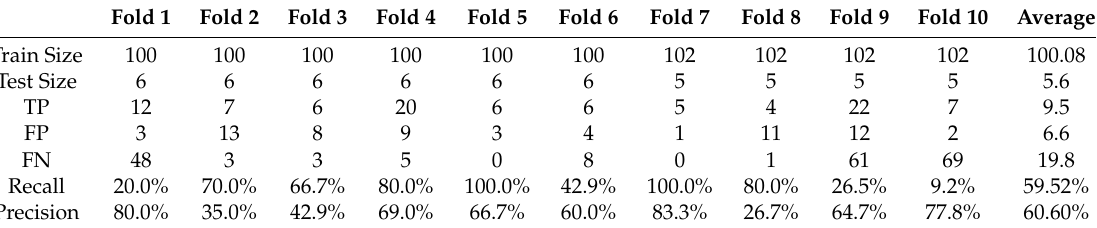
Table A4. The Results of Experiment 4: Augment the complete dataset (Dataset 4).